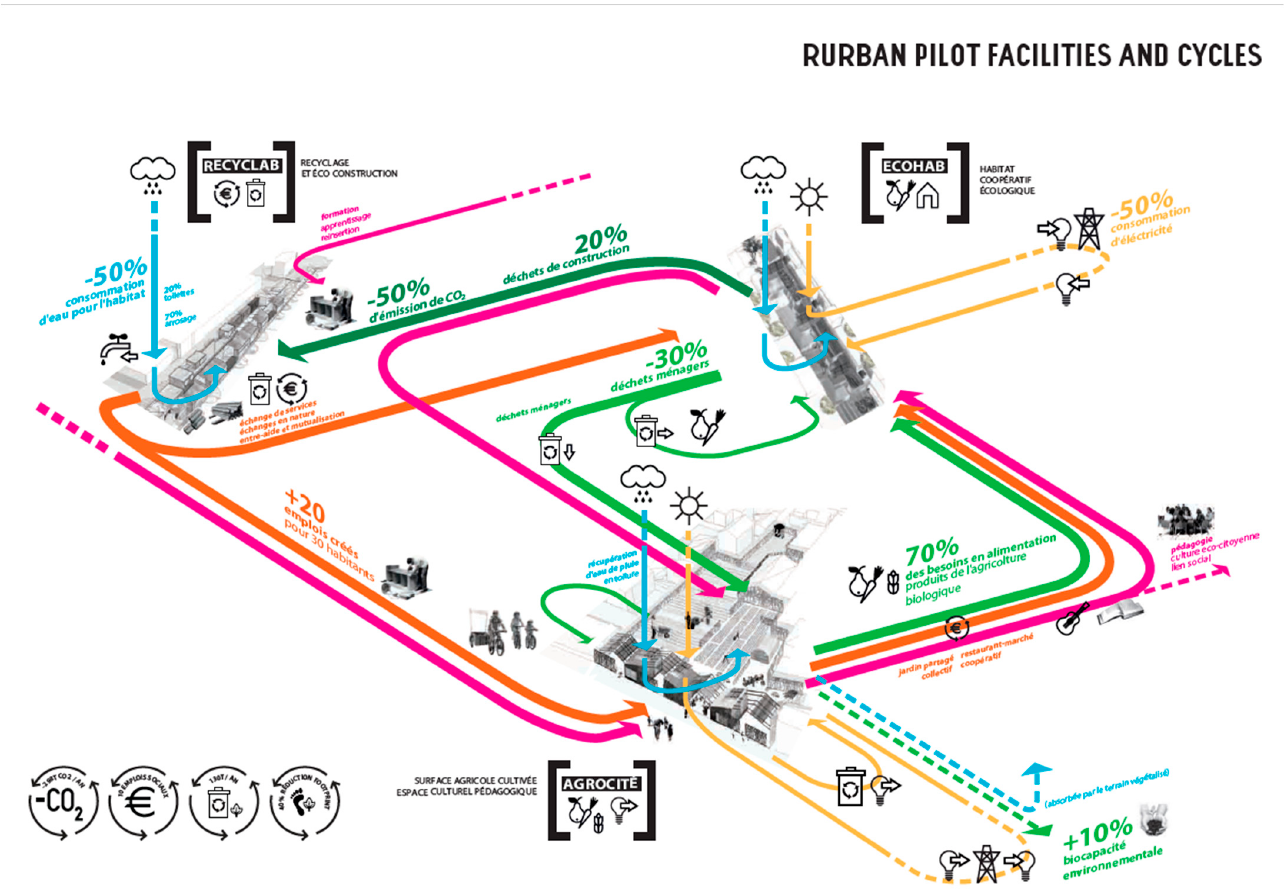
Figure 7. Petrescu and Petcou’s R-Urban concept, adapted to reflect their realizations on the ground in the Paris region. It illustrates a project that the designers implemented in two Paris suburbs, composed of three interrelated units: (1) Agrocité (combining an agricultural production area and a pedagogical and cultural space); (2) Ecohab (ecological cooperative housing); and (3) Recyclab (recycling and ecological construction). Image courtesy of Petrescu and Petcou.